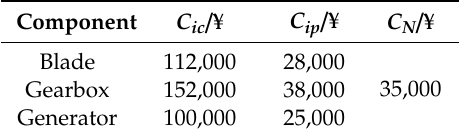
Table 5. Maintenance costs for the major components of wind turbines.